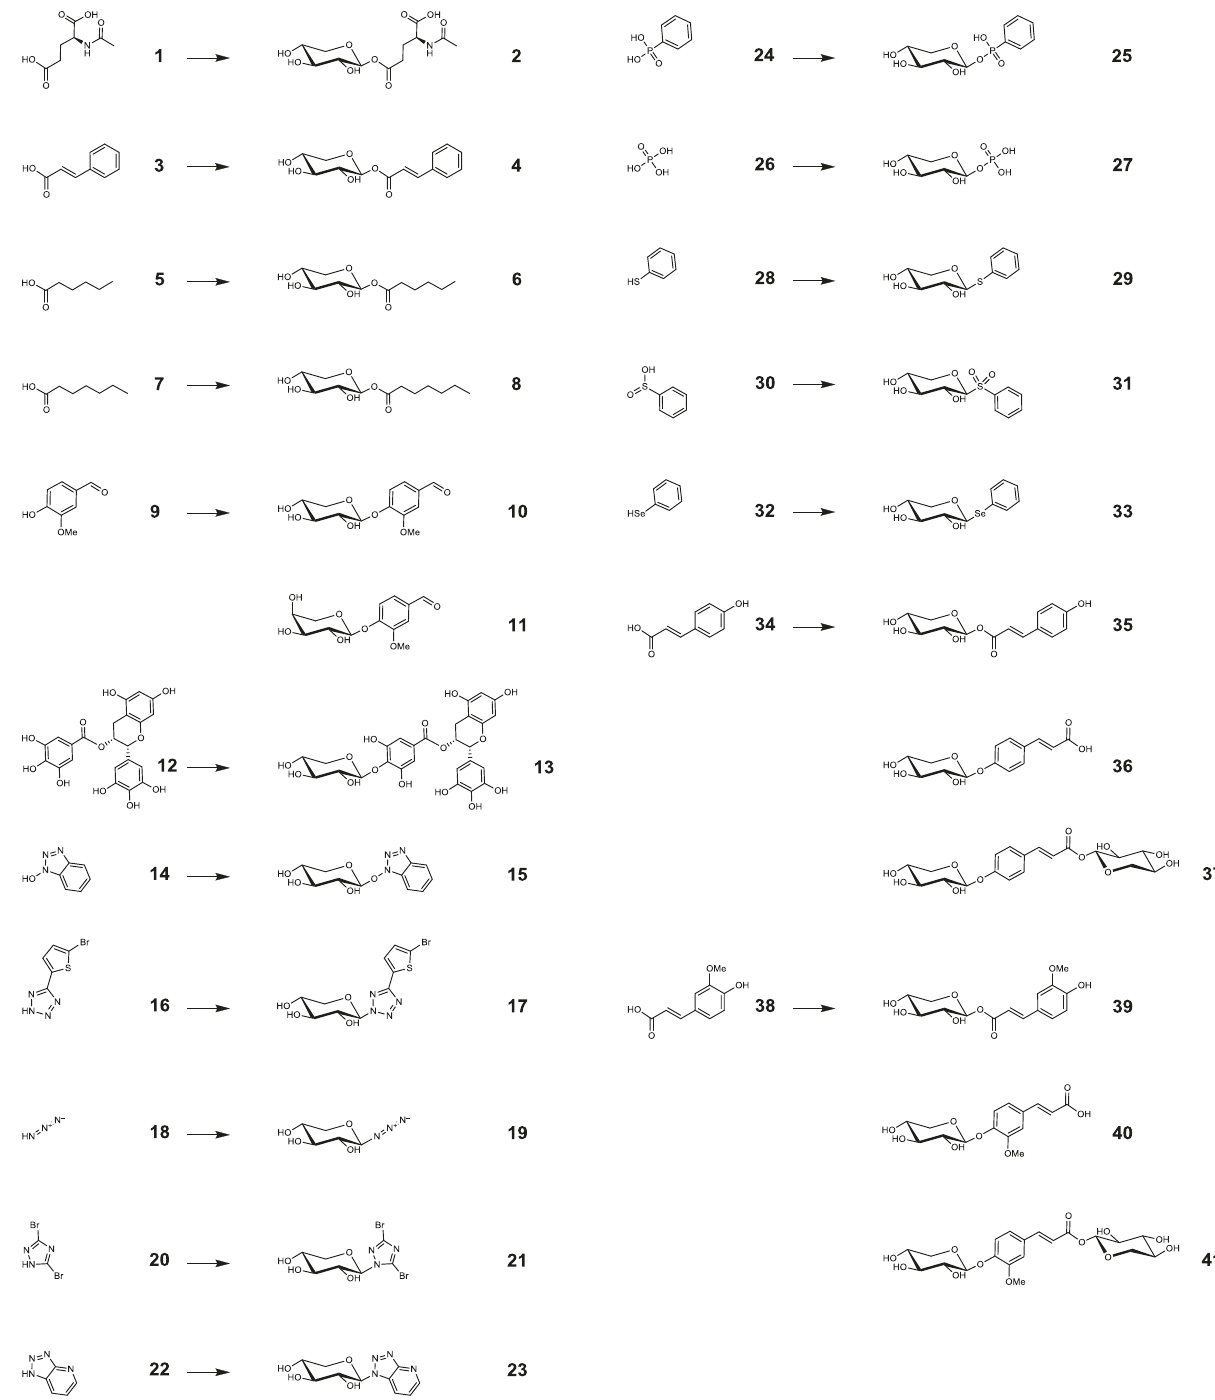
Fig. 2 Acceptors and their derived glycosides identi fi ed by NMR. Bold numbers are used to identify the acceptors (Tables 1 and 2) and their corresponding